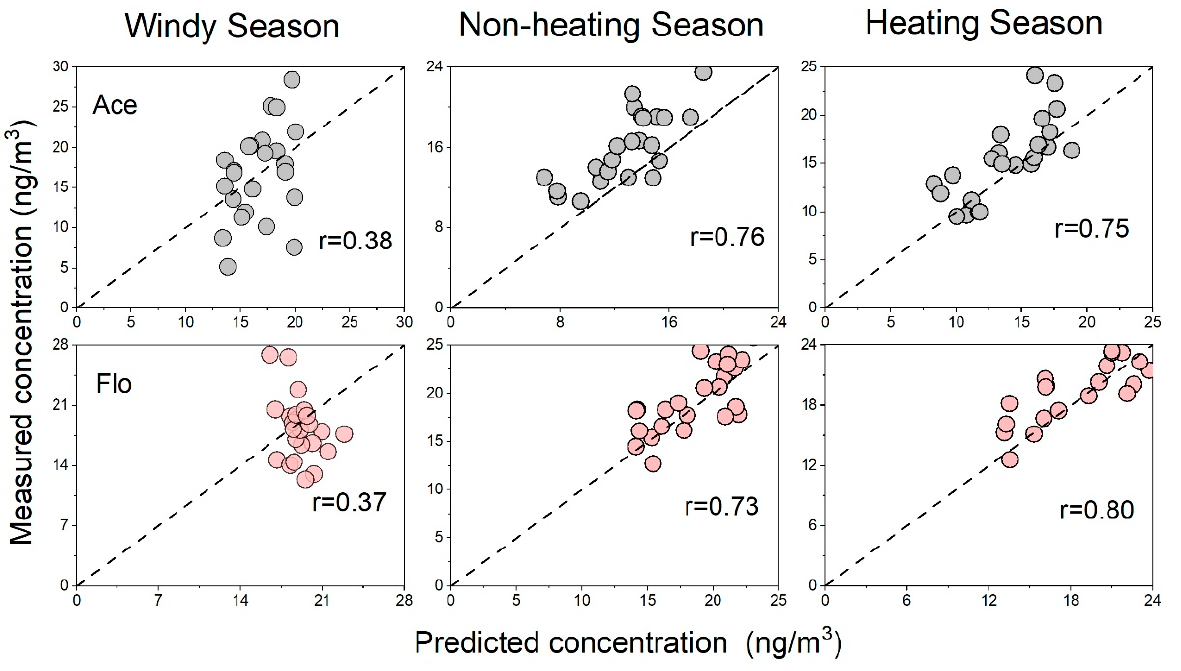
Figure 3. Results of leave-one-out cross-validation for gaseous PAHs LUR models: predicting concentrations ( x -axis) against measured concentrations ( y -axis) for LUR models.